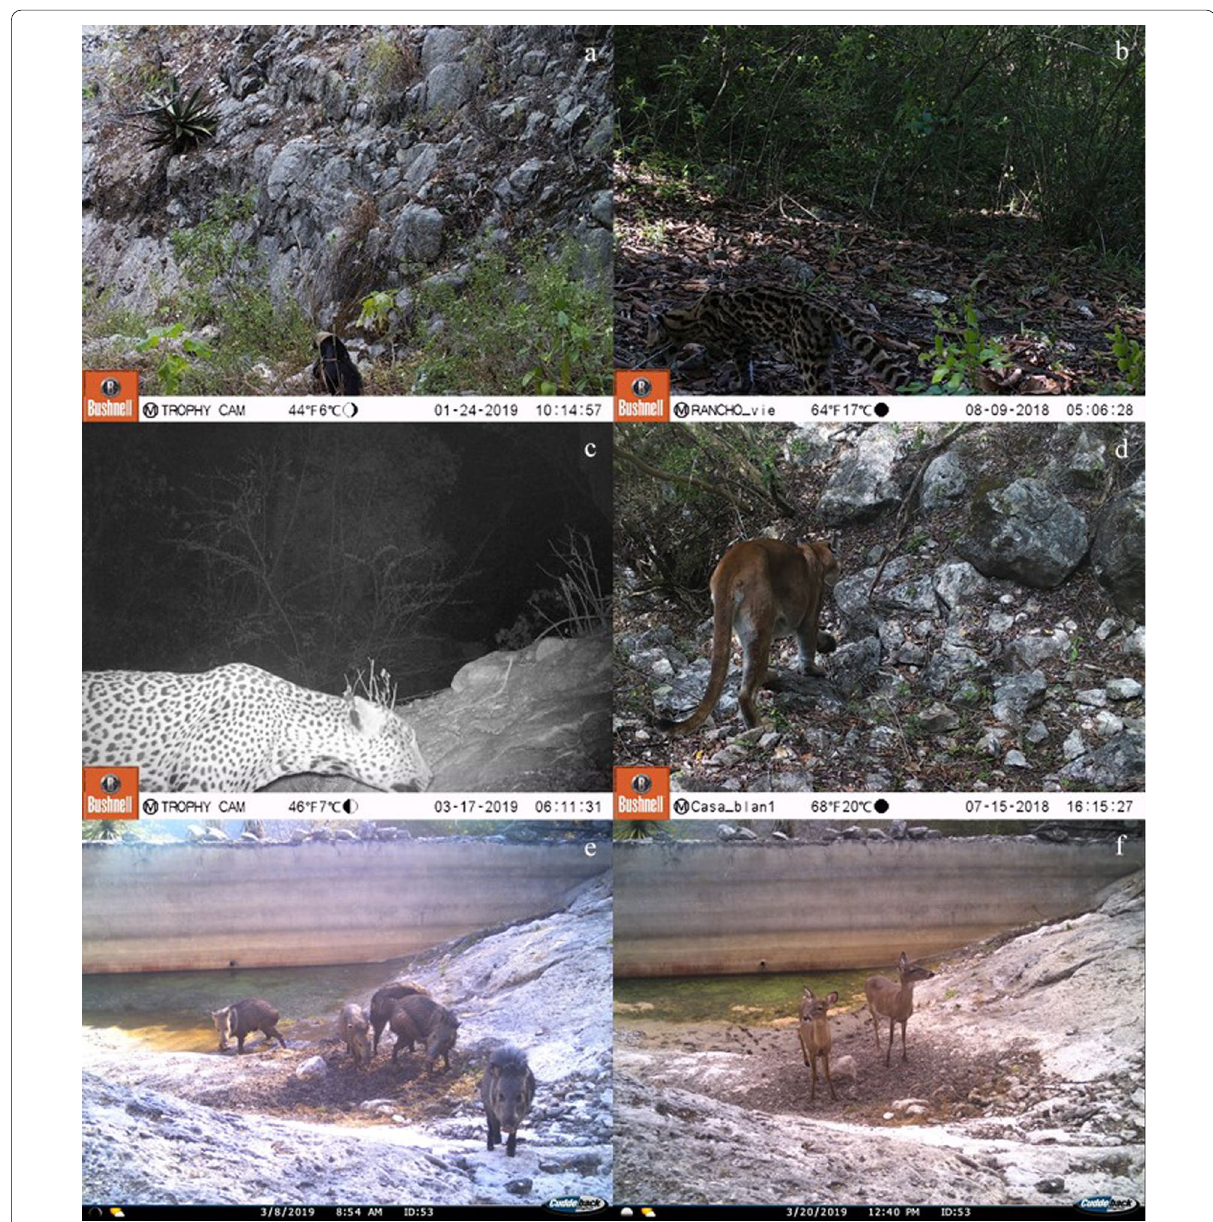
Fig. 3 Records of terrestrial mammals in riparian and non‑riparian corridors. a Tayra, b margay, c jaguar, d cougar, e collared peccary, f white‑tailed deer, g Ringtail, h gray fox, i American hog‑nosed skunk, j hooded skunk, k Western spotted skunk, l racoon, m Mexican gray squirrel, n mouse, o Virginia opossum, p cattle, q